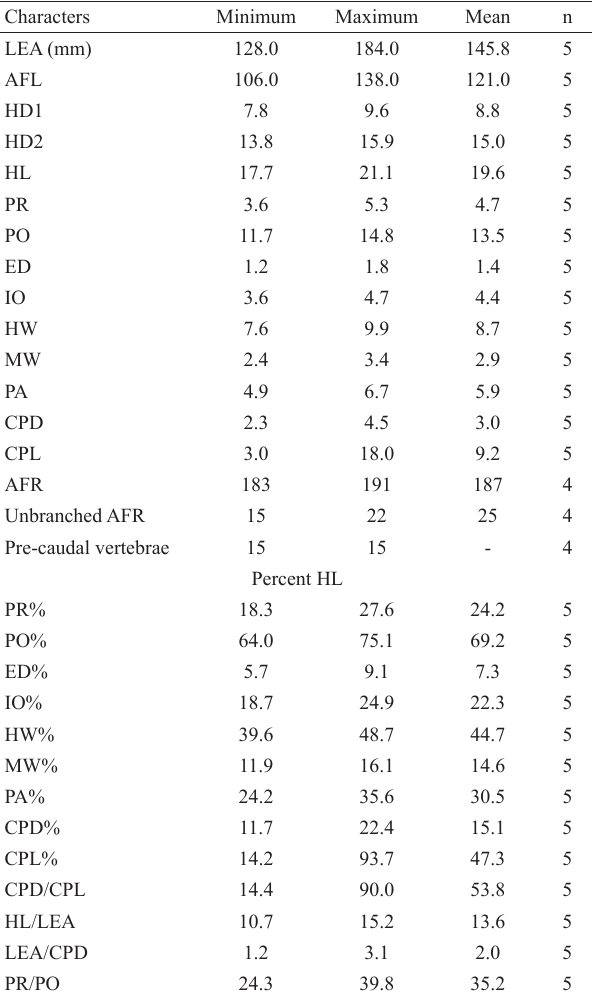
Fig. 25. Sternarchella sima paratype (AMNH 3864). a. Lateral view of the body, b. Lateral view of the head, c. Lateral view of the caudal region showing a single row of intermuscular bones in the caudal peduncle and a discontinuous caudal peduncle membrane. Scale bars = 1 cm. Tab. 10. Morphometrics and meristic measurements for Sternarchella sima